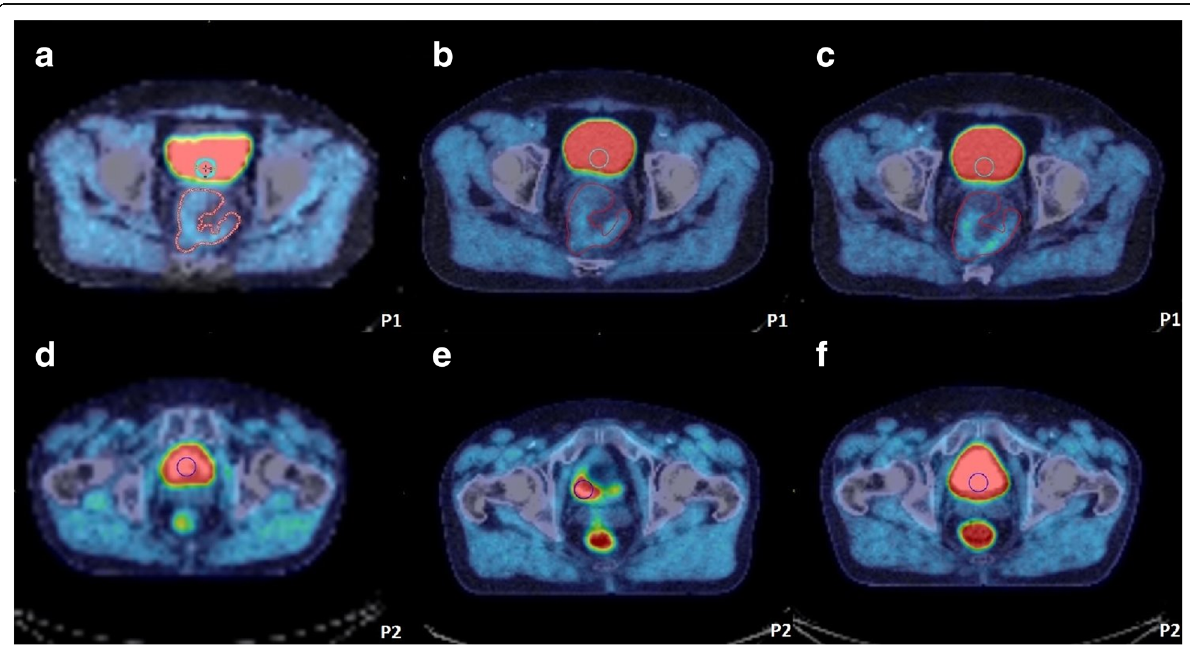
Fig. 4 Examples from non-enema group showing PET-CT scans at 45 min ( a , d ), 2 h ( b , e ) and 4 h ( c , f ) for 2 subjects in whom dynamic analysis was performed. The blue circular ROI of 10 mm radius was drawn on three consecutive slices in the bladder and red ROI encompassing the whole tumour. a – c show patient 1 (P1) tumour boundary in close proximity to the bladder. d – f show that patient 2 (P2) emptied the bladder before the 2 h scan as seen from the reduced volume/activity in the bladder in e compared with d and f . The bladder activity reaccumulated at 4 h ( f ) compared to 2 h ( e ). The accumulation of tracer within the rectum in images d – f is two transaxial slices distal to the tumour (not visible on these slices) and is ascribed to luminal excretion of the tracer. PET = positron emission tomography; CT = computed tomography; min = minute; h = hour; ROI = region of interest; mm =